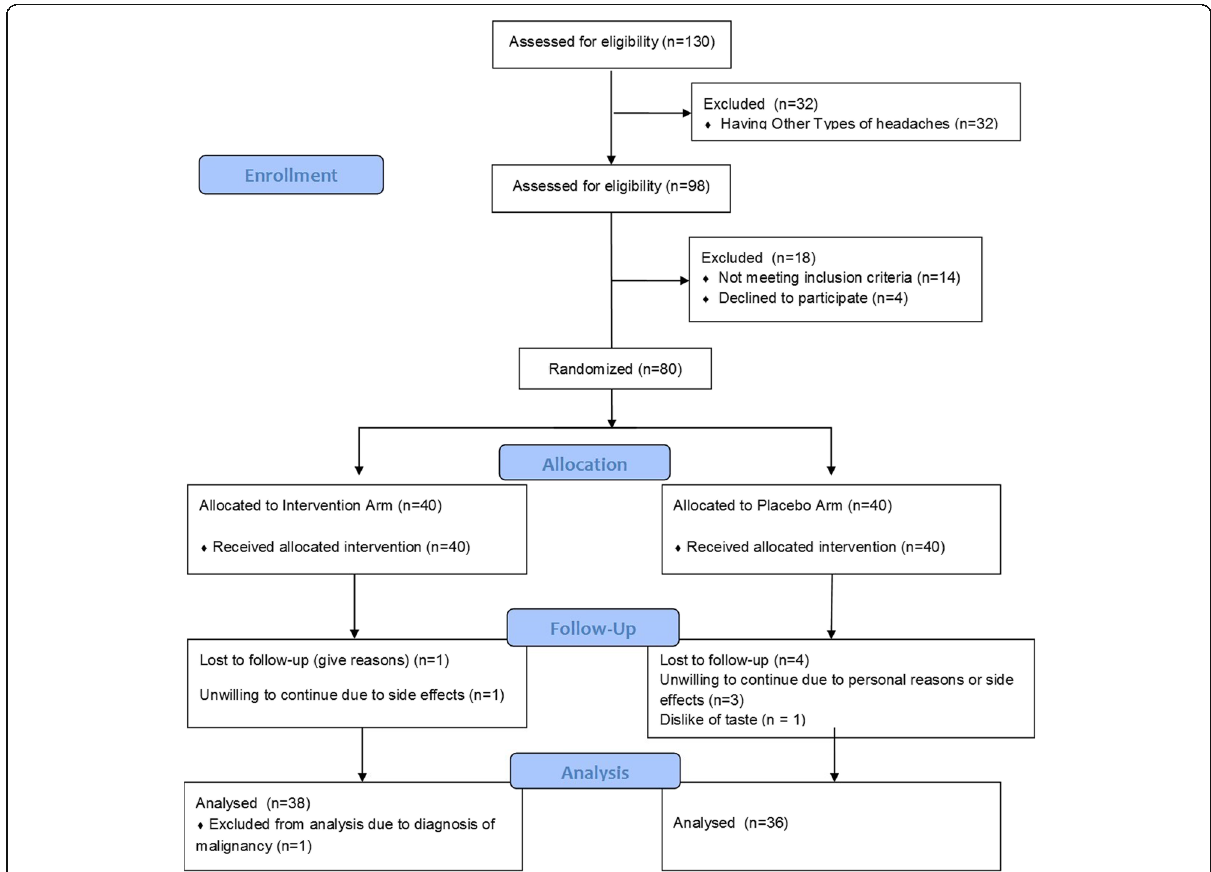
Fig. 1 Flow-Diagram of Studied